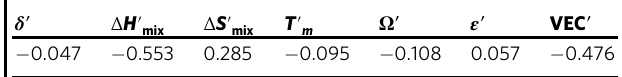
Table 1 The standardized canonical weights found in the CCA with hardness as the sole output